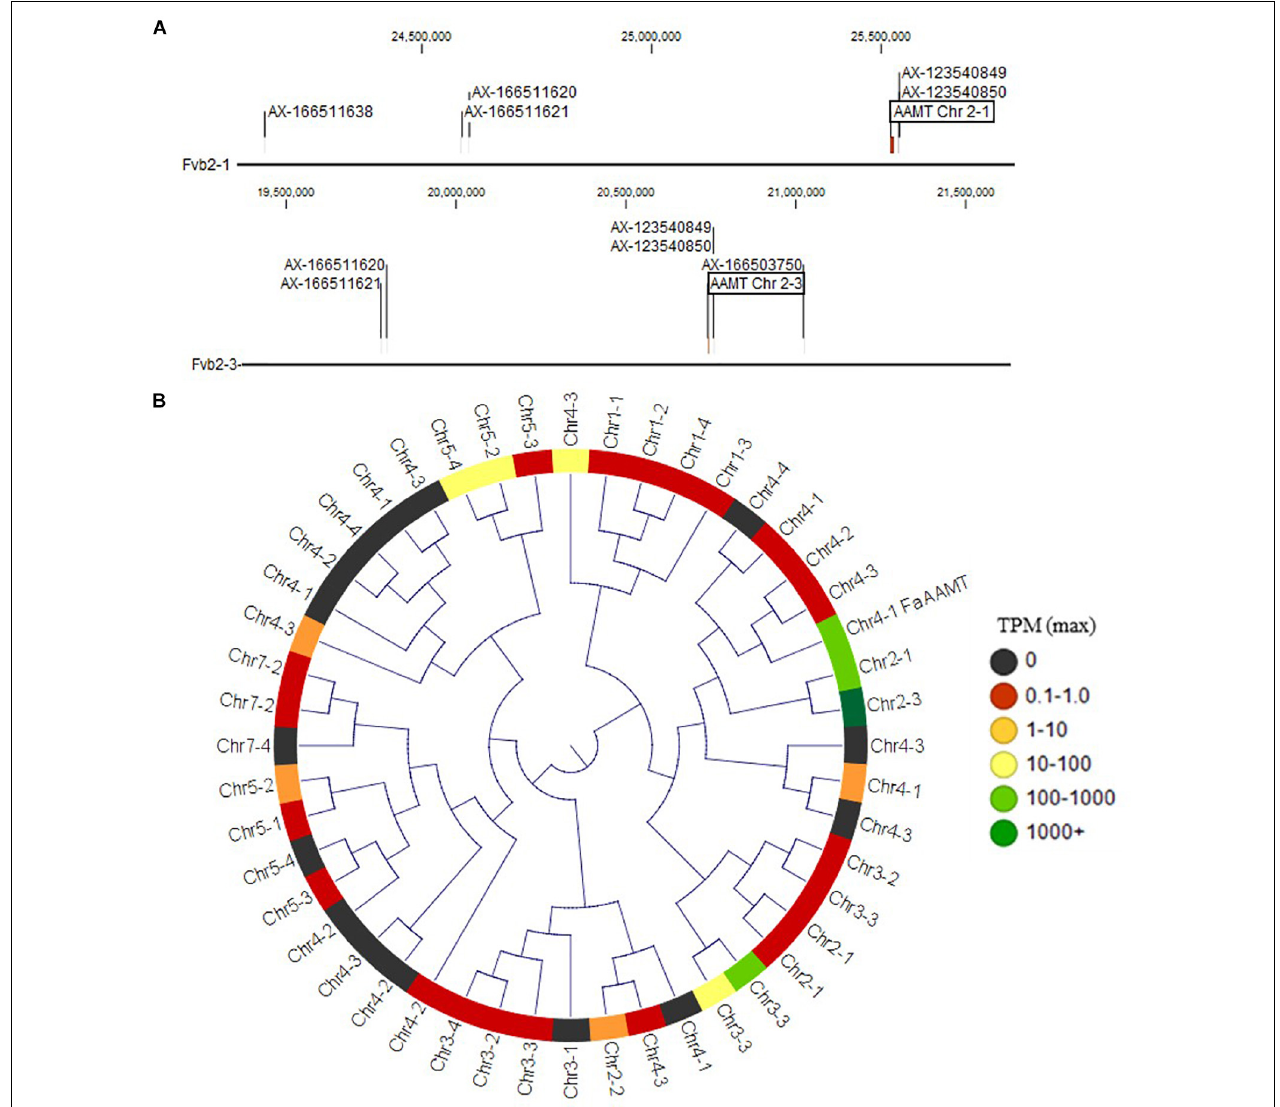
FIGURE 2 | Methyl ester and methyl anthranilate candidate genes. (A) The Chr 2 methyl ester QTL markers correspond to two homoeologous physical regions containing anthranilic acid methyl transferase-like ( AAMT-like ) genes on Chr 2-1 (top) and Chr 2-3 (bottom). (B) AAMT-like deduced proteins in the “Camarosa” genome are shown in a neighbor-joining cladogram, with transcript abundance heatmaps representing the highest TPM detected among the fruit transcriptomes. The Chr 2-1 and Chr 2-3 AAMT-like candidates are highly identical to the published AAMT-like “Camarosa” homolog (Chr 4-1 FanAAMT ) and are highly abundant transcripts in the